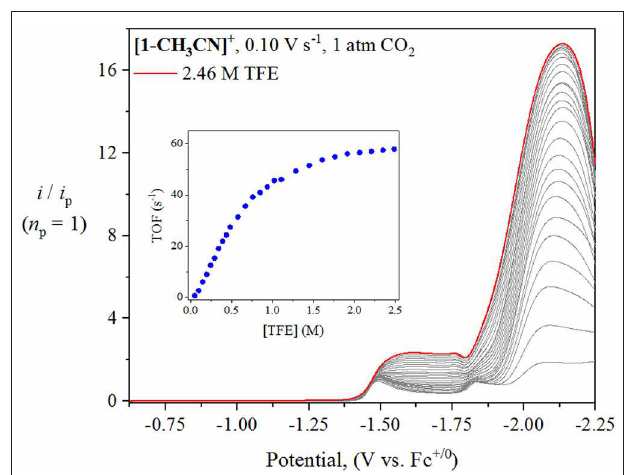
FIGURE 7 | Linear sweep voltammetry of [1-CH 3 CN] + recorded at υ = 0.1V s − 1 under 1 atm CO 2 with increasing TFE concentration (0–2.46M). The current (y-axis) data are normalized with respect to the non-catalytic Faradaic response ( i p ). The inset plot of ‘TOF vs. TFE concentration’ demonstrates that zero-order conditions with respect to TFE concentration were achieved at 2.0M TFE.